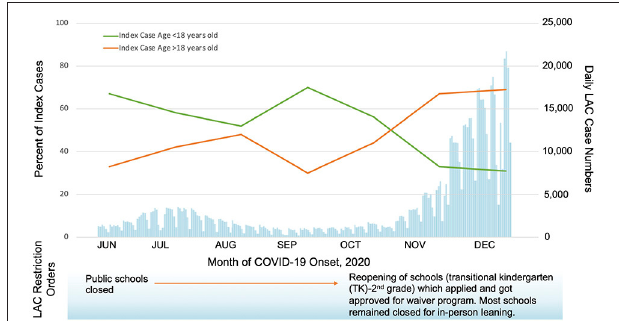
FIGURE 1 | Laboratory-confirmed index cases by age group in participating households compared to Los Angeles County (LAC) daily case numbers, June-December 2020 (23). Household index cases were predominantly children during low community transmission (before November 1, 2020) and adults during the high community transmission period (after November 1, 2020), χ 2 = 7.647, p = 0.006.